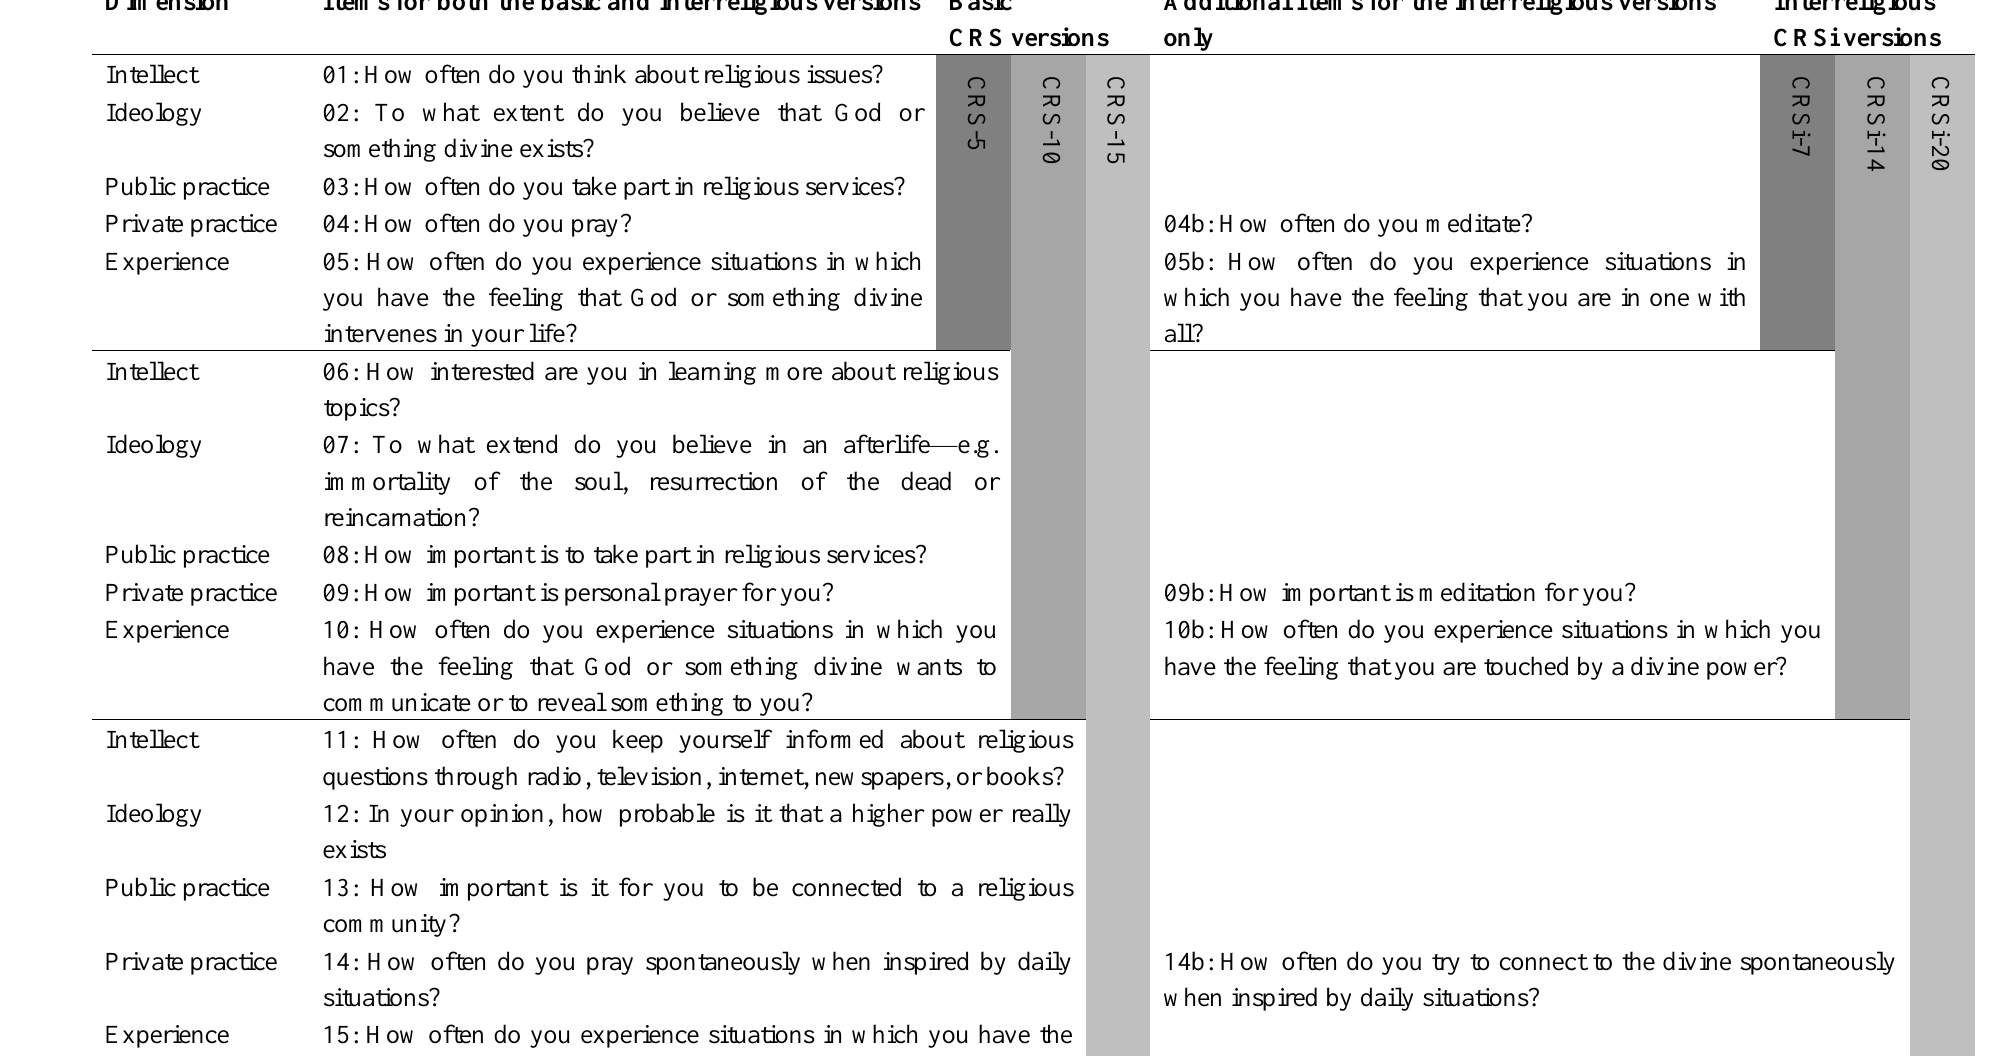
Table 1. Items and versions of the Centrality of Religiosity Scale (CRS)—English versions. Dimension Items for both the basic and interreligious versions Basic